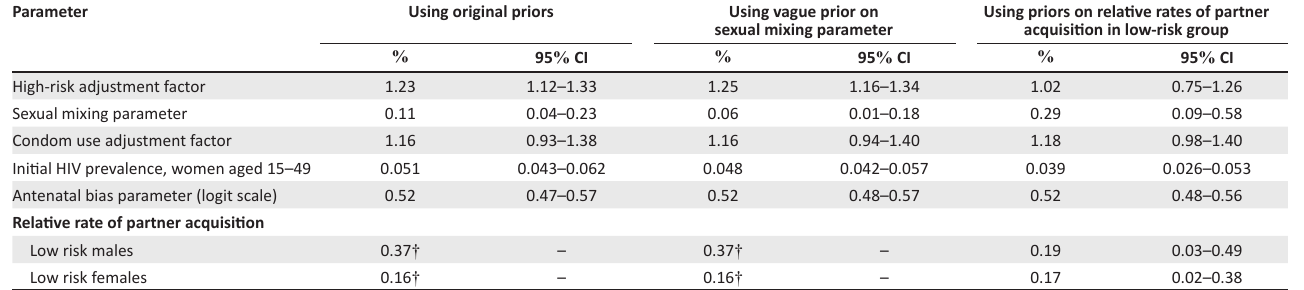
TABLE 4: Posterior estimates for Gauteng with different prior distributions. Parameter Using original priors Using vague prior on